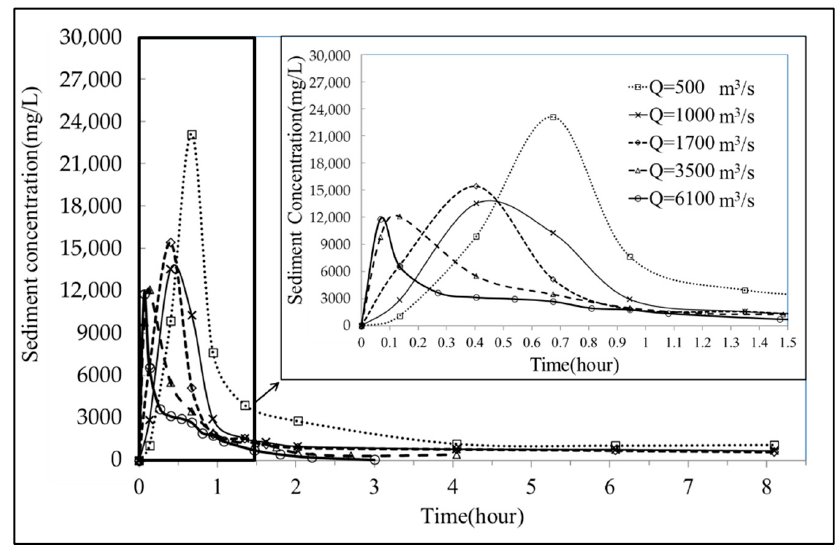
Figure 10. Hydrographs of concentrations of sediment with a water content of 40% at various reservoir flood discharges.